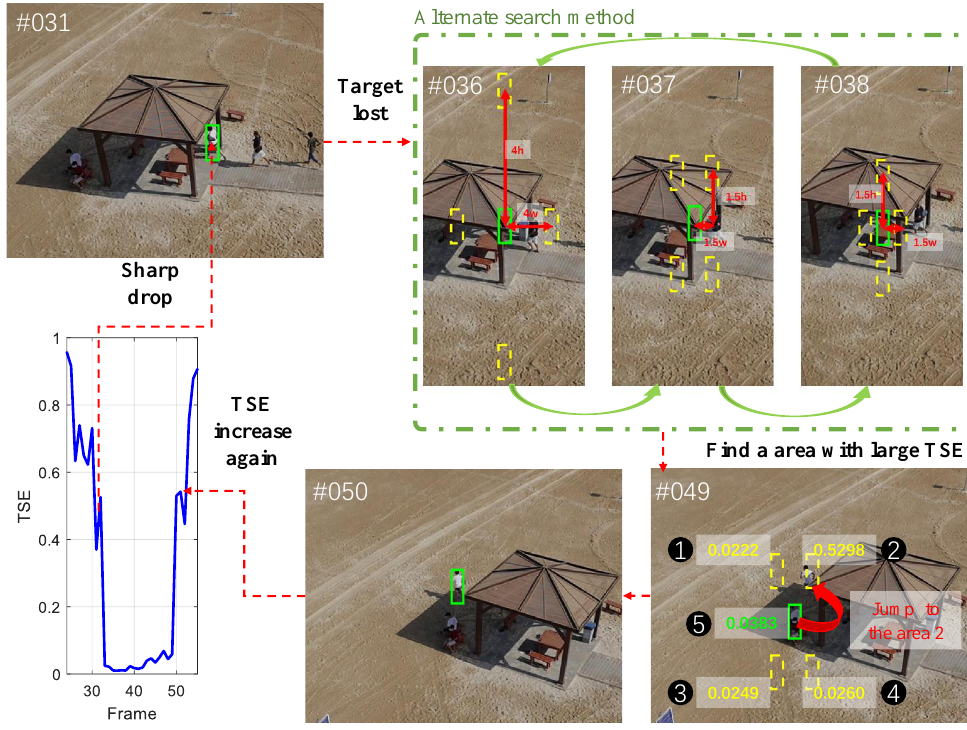
Figure 4. Diagram of lost-and-found